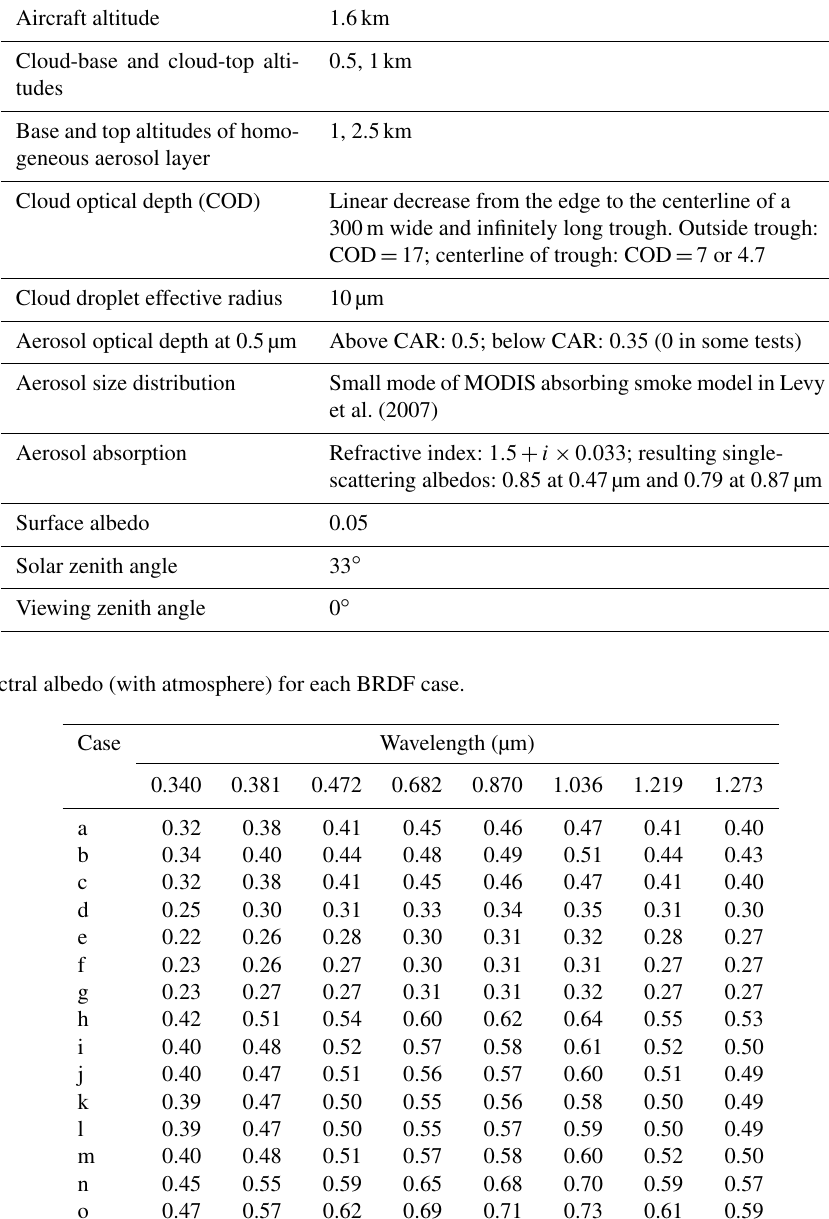
Table 3. Key parameters of the simulations used for exploring the impact of three-dimensional radiative processes. Parameter